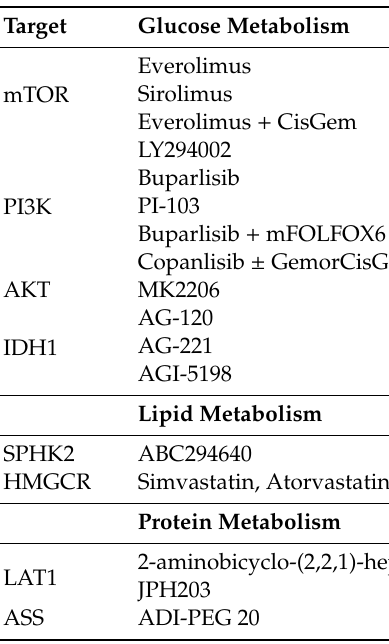
Table 2. Metabolic targeted therapy in